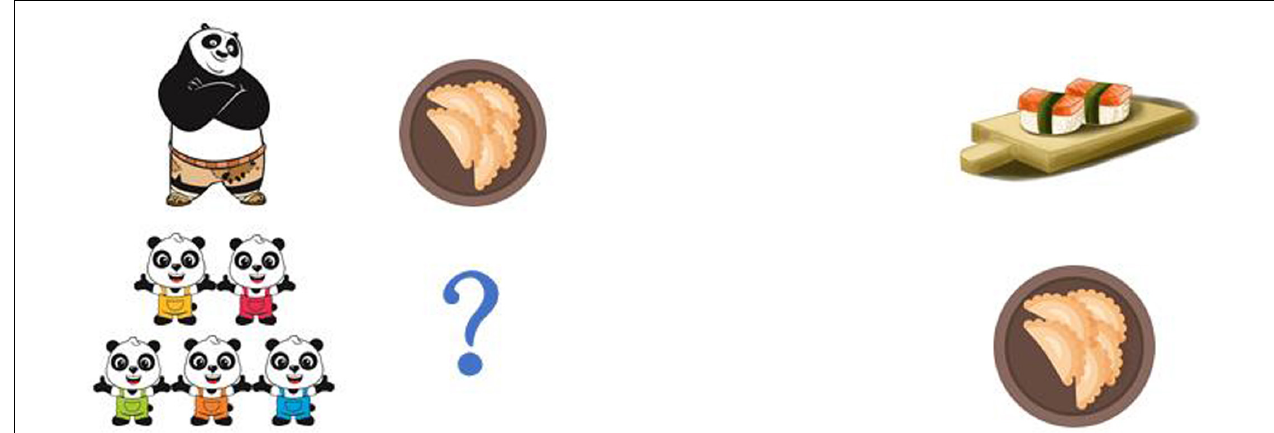
FIGURE 1 | Sample test scene for sentences in